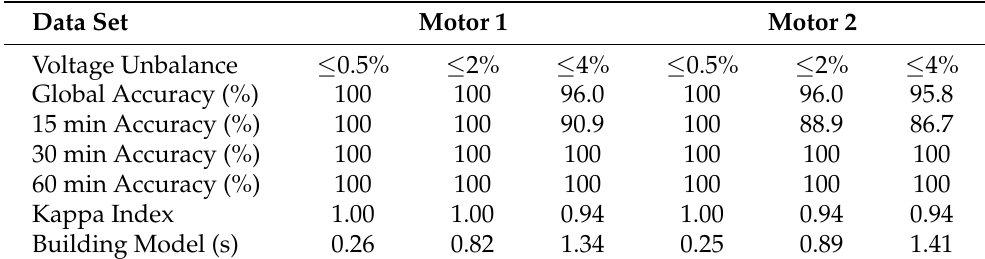
Table 4. Experimental results using the 150 SMI attributes between phase currents i a and i b —Severity analysis of bearing